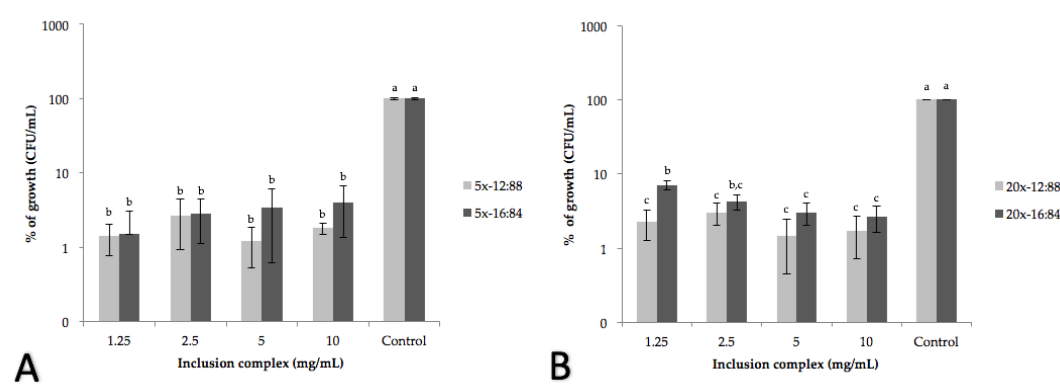
Figure 5. Growth of Salmonella typhi ( A ) and Listeria monocytogenes ( B ) at di ff erent concentrations of 5x and 20x concentrated oil inclusion complexes at 12:88 and 16:84 ratios, respectively. Data were analyzed by analyses of variance test (one-way ANOVA) and a post hoc test of Tukey’s multiple range. Di ff erent letters (a, b, c) above bars are significantly di ff erent ( p < 0.05).